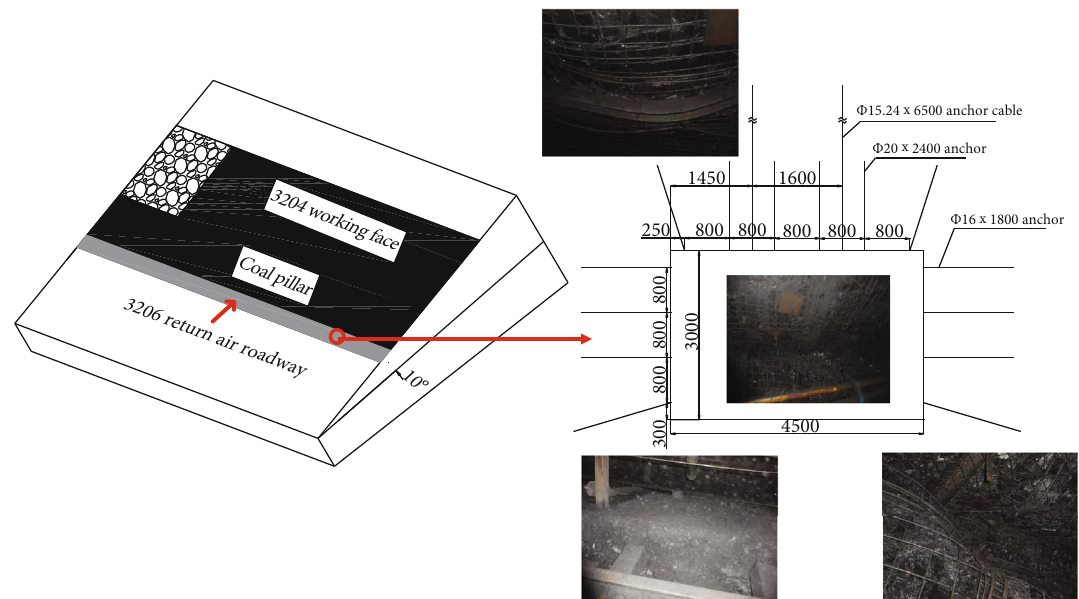
Figure 4: Schematic diagram of original support and failure (unit: